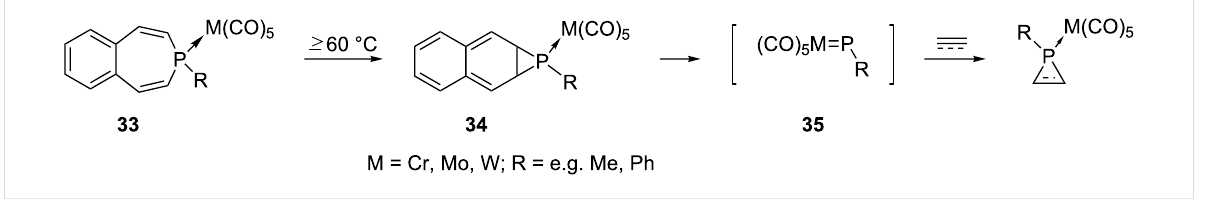
(Scheme 7) also showed a flattened-boat conformation ( α = 40.5°, β = 28.2°) [5] compared to the metal-free parent structure ( α = 48.3°, β = 27.8°), computed at the B3PW91/6- 311+G(d,p) level